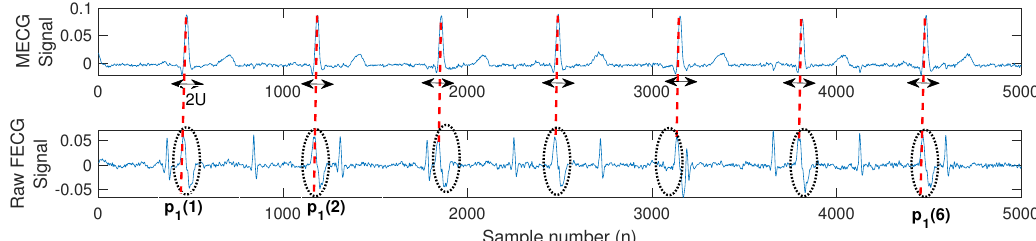
( 1 ) , p ( 2 ) , . . . , p ( 6 ) ) 1 1 1